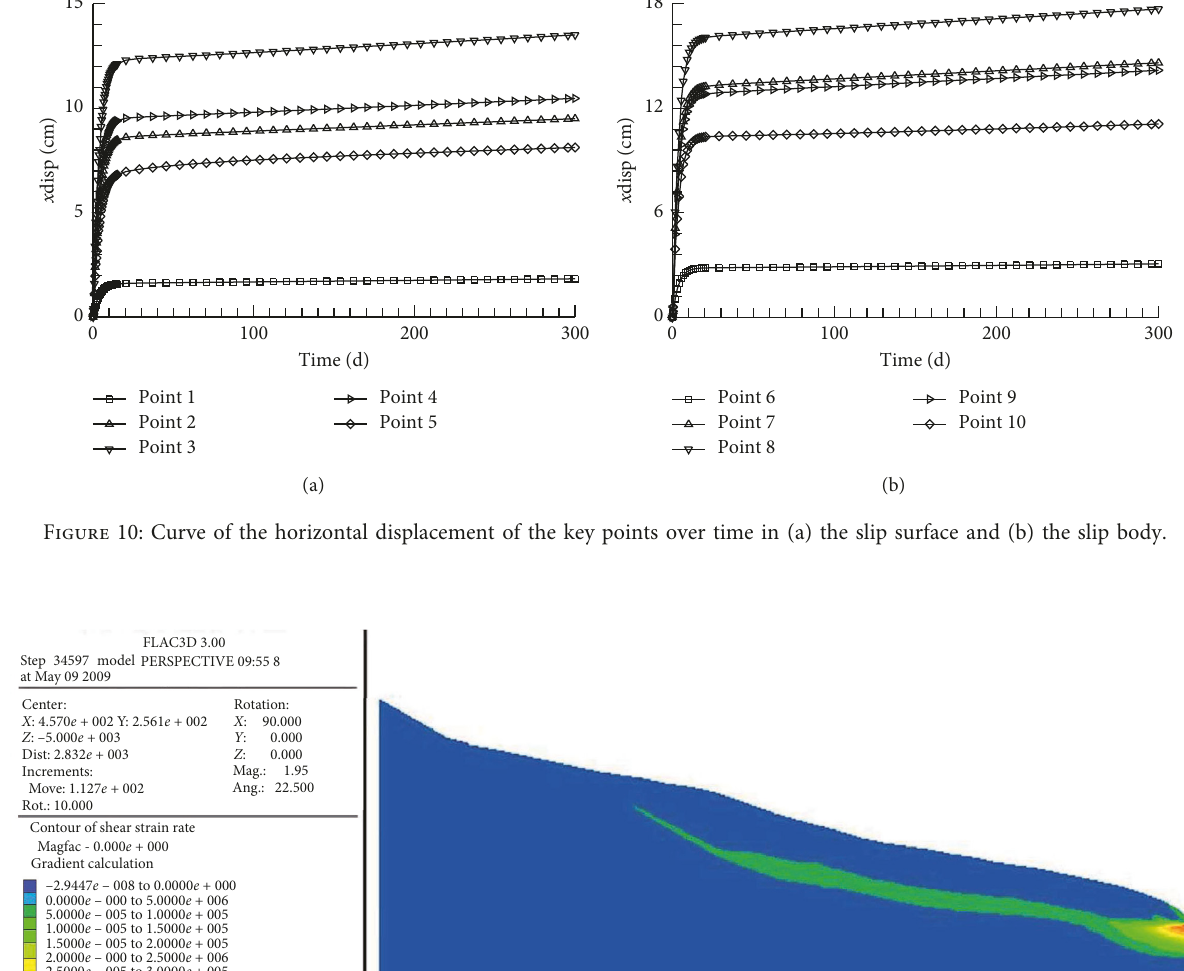
Figure 11: Calculation results of elastoplastic strength reduction